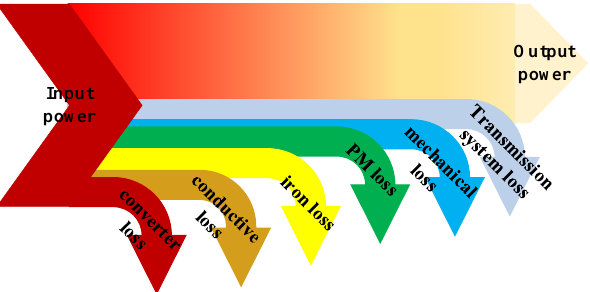
Figure 3. The various loss components of an electric machine used in propulsion system of EVs.